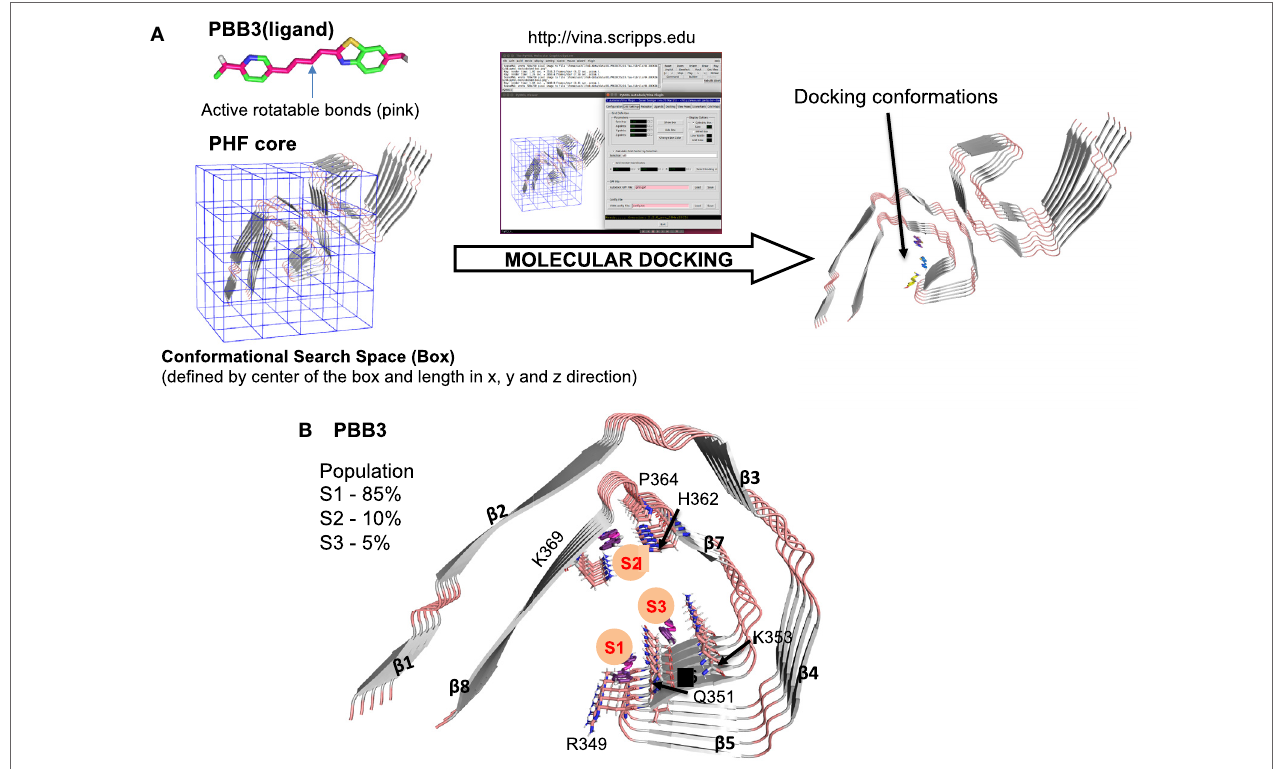
FigURe 3 | Molecular docking of PBB3 to paired helical Tau filaments (PHFs) from Alzheimer’s disease brain. (A) Schematic representation of the docking process using Pymol and AutoDock Vina. The PHF core structure was from Ref. (51) (PDB ID: 503L). Out of 100 docking conformations, the top 20 were selected for further analysis. (B) Molecular docking of PBB3 into the PHF protofilament core structure. The top 20 conformations distributed into three clusters (S1, S2, and S3). S1 had the highest affinity for the Tau filament, followed by S2 and